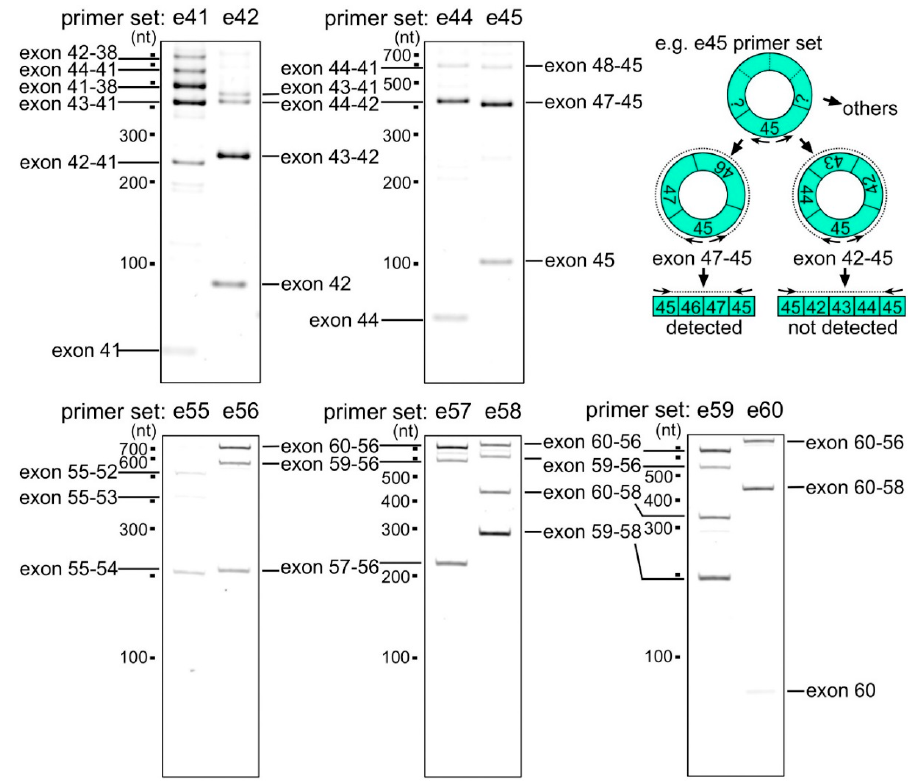
Figure 5. Expression analysis of small circRNAs by divergent reverse-transcription polymerase chain reaction (RT-PCR). Primer sets were designed for each exon and are indicated at the top of the panels. Molecular markers are shown on the left of each panel. The exons involved in back-splicing to generate circRNAs are indicated on either side of the panels. The upper right panel indicates that the exon 47–45 circRNA product was successfully detected using e45 primers. However, circRNA products that have both exon 44 and 45, such as the exon 45–42, were not detected by the e45 primers. Sequences of primer sets (e41, e42, e44, e45, and e55–e60) are indicated in Supplementary File